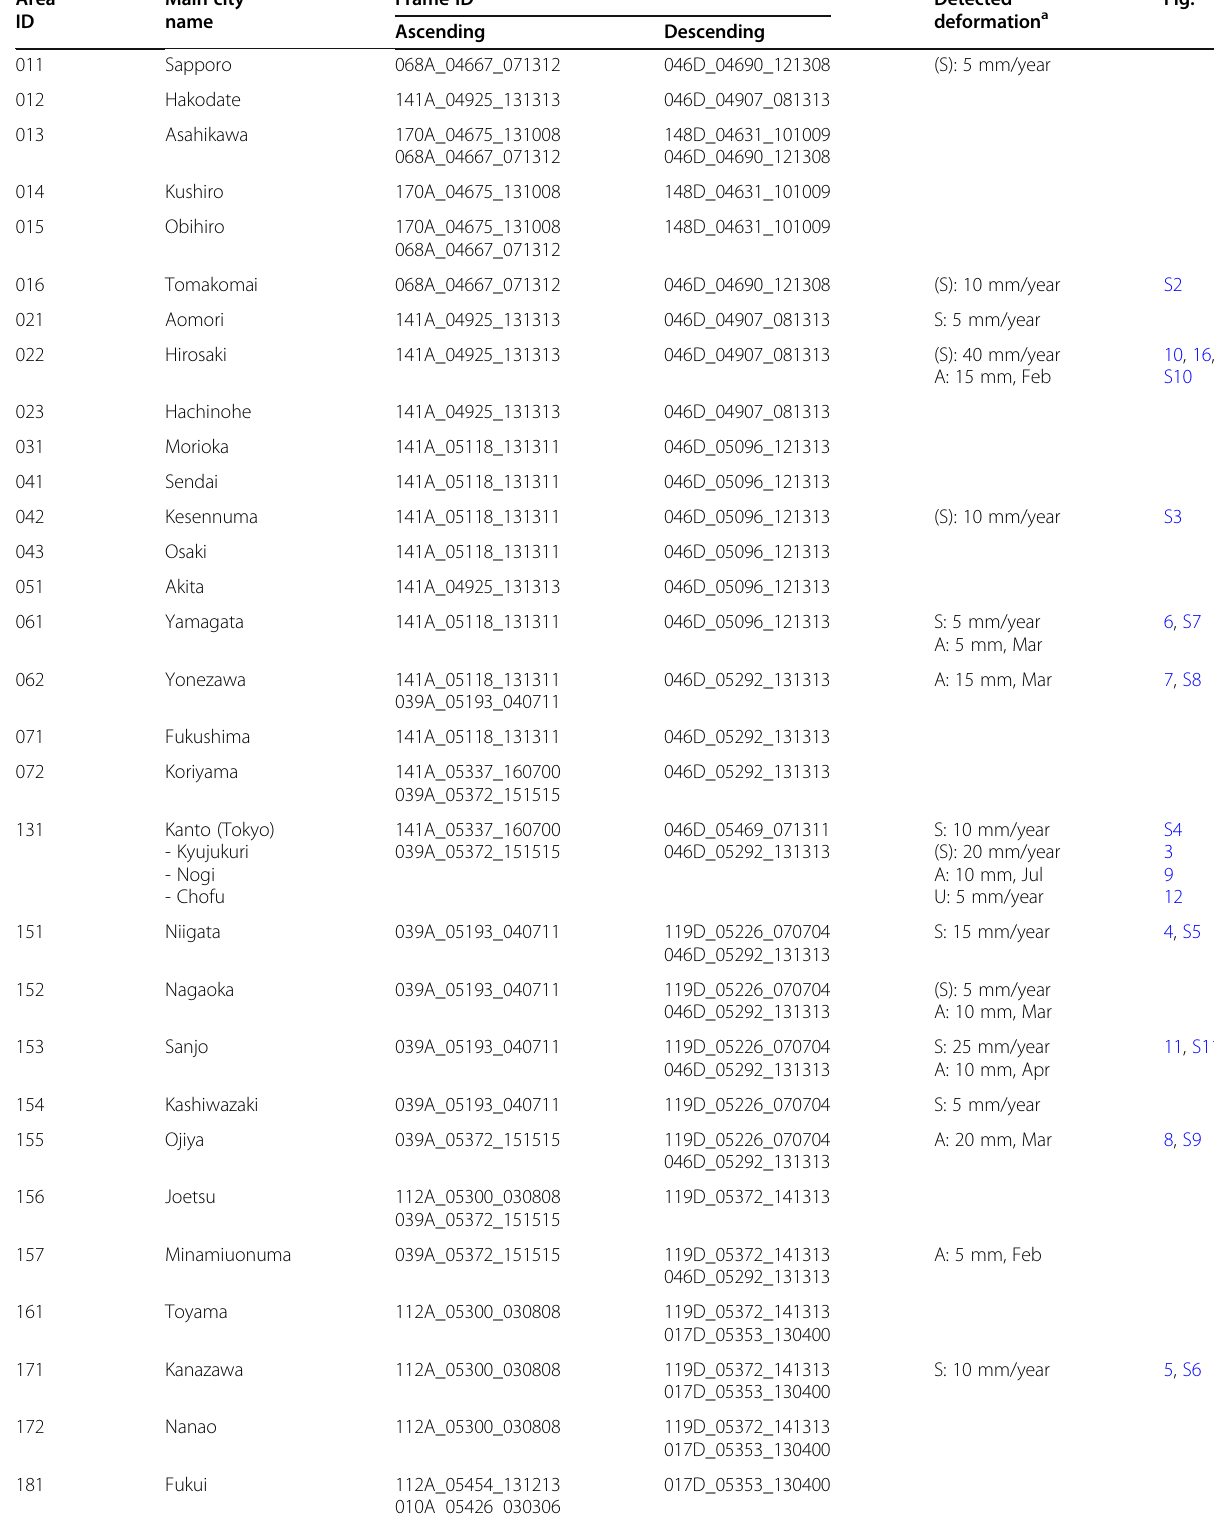
Table 2 Target urban areas, corresponding frame ID, and detected deformation